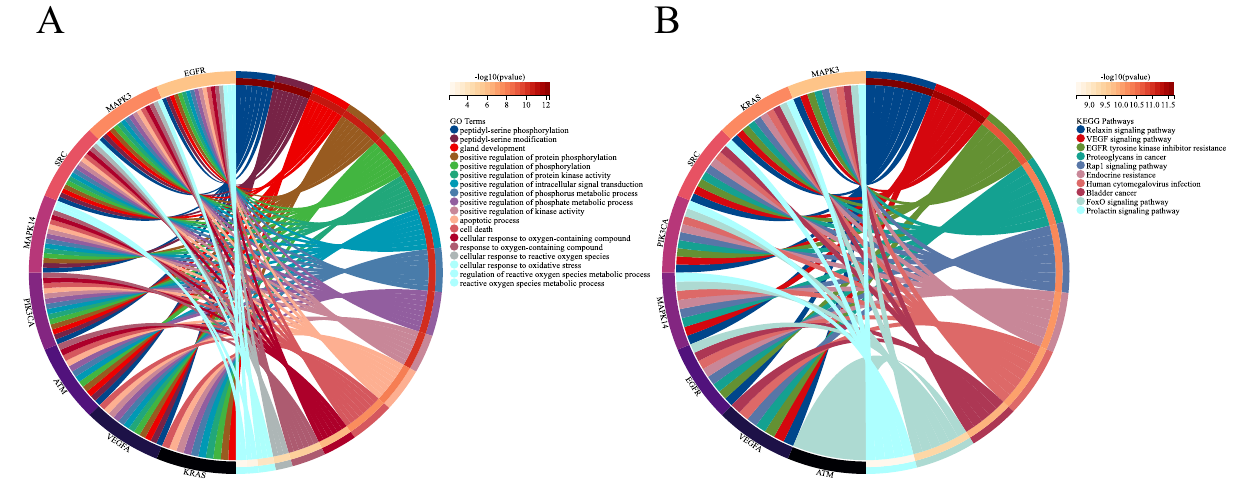
Figure 4. GO and KEGG enrichment analysis of Hub LN-FRGs related to LN. ( A ) GO term of Hub LN-FRGs. ( B ) KEGG enrichment of Hub LN-FRGs. The genes are linked to their assigned pathway terms via colored ribbons and are ordered according to the observed log10 P value, which is displayed in descending intensity of red squares next to the selected